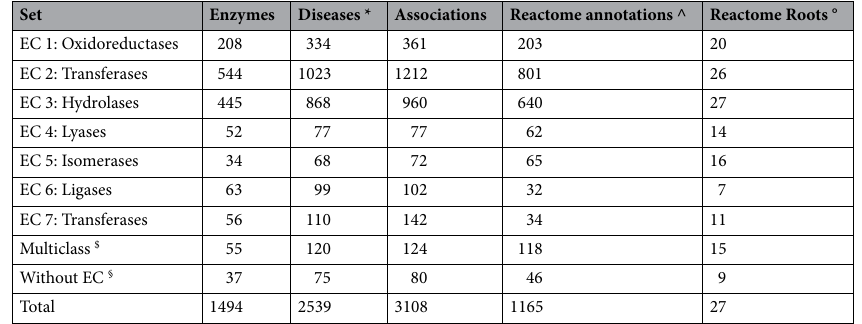
Table 2. Enzyme classification. * The same disease can appear in more than one list, ^ the same Reactome term can appear in more than one list; ° the same Reactome root can appear in more than one list. $ Multiclass: enzymes endowed with two or more EC level 1 classifications. § Without EC: enzymes annotated with the GO term “Catalytic activity” and not endowed with an EC classification.